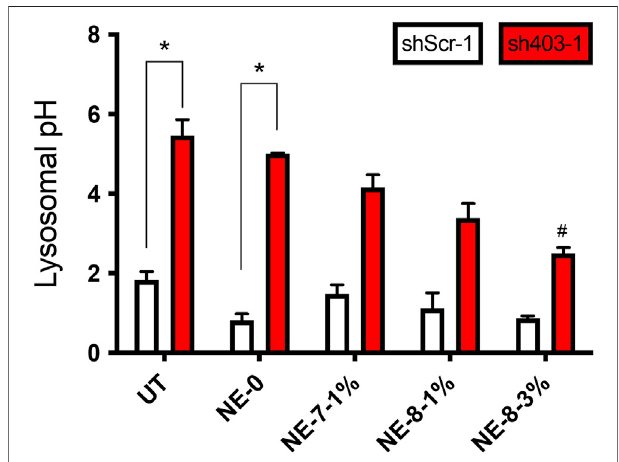
FIGURE 3 | Acidic NEs rescue lysosomal pH in vitro . Lysosomal pH values in control (shScr-1) and ATP13A2-depleted (sh403-1) M17 cells, in the absence or presence of different NEs. *, p < 0.05 compared with shScr-1 untreated cells; #, p < 0.05 compared with sh403-1 untreated cells.